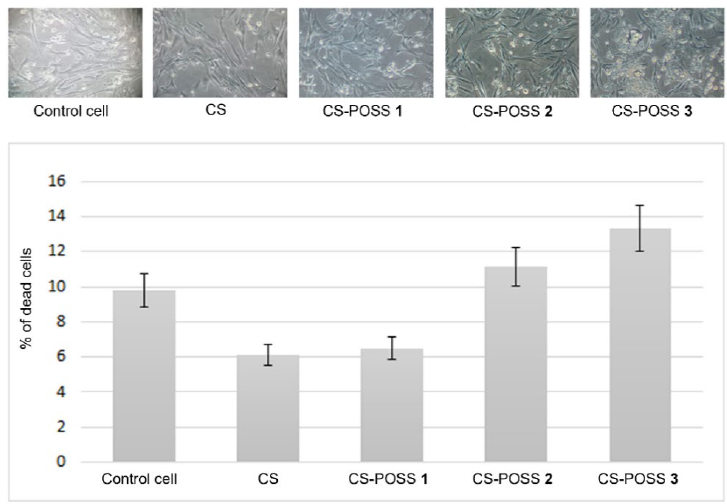
Figure 6. Results of MTT test for the assessment of the assayed hydrogel biocompatibility in hFOB 1.19. Each value represents the mean ( ± SD) of the percentage of dead cells in the experiments made in triplicate.